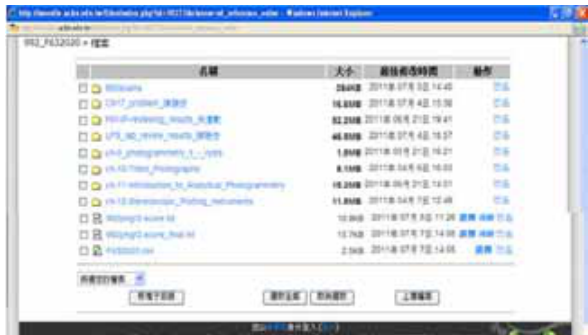
Figure 8. Functions for managing files and directories on NCKU Moodle